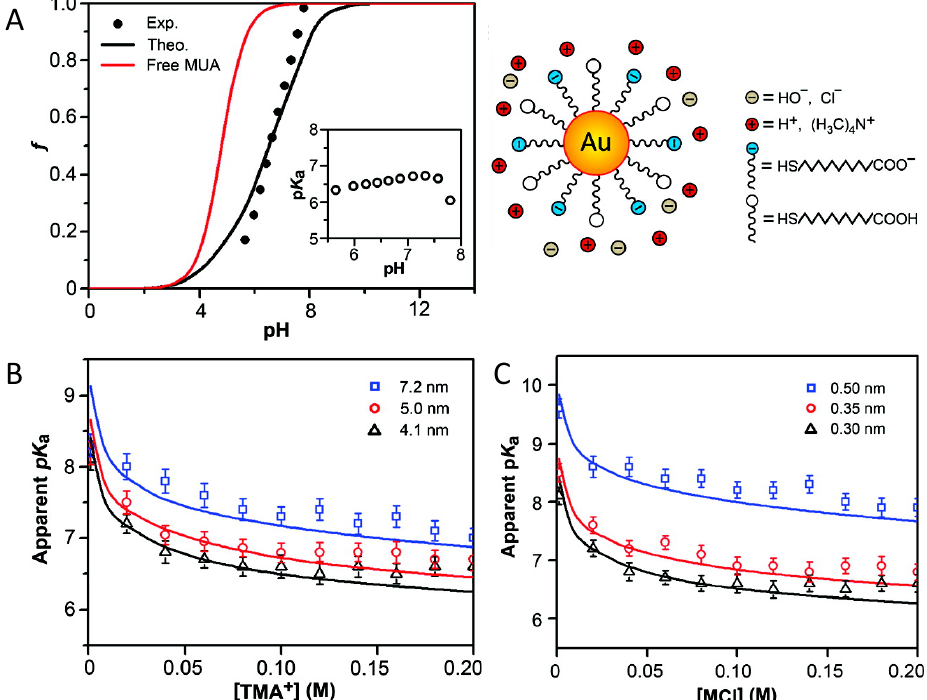
Figure 1. ( A ) Fractions of dissociated mercaptoundecanoic acid (MUA) ligands as a function of pH for a NP of D = 4.1 nm. The theoretical charge fraction (black curve), f , was calculated with the molecular theory (MT). The calculated value corresponding to free MUA in solution using the Henderson–Hasselbalch equation is plotted in red. The inset shows the experimental pK a of NP’s ligands. The salt concentration (tetramethylammonium chloride (TMACl)) is 0.08 M. ( B ) The apparent pK a of Au-MUA NPs of different sizes plotted as a function of TMACl concentration. ( C ) The apparent pK a of Au-MUA NPs of D = 4.1 nm as a function of the salt concentration for different salt cations (the anion is always Cl − ). R = 0.30, 0.35, and 0.50 nm correspond to the radii of TMA + , TEA + , and TBA + , respectively. Open markers correspond to experimental data; lines were calculated with MT. pK a for free MUA is ~4.8. (Reprinted with permission from the authors of [26]. Copyright 2011 American Chemical